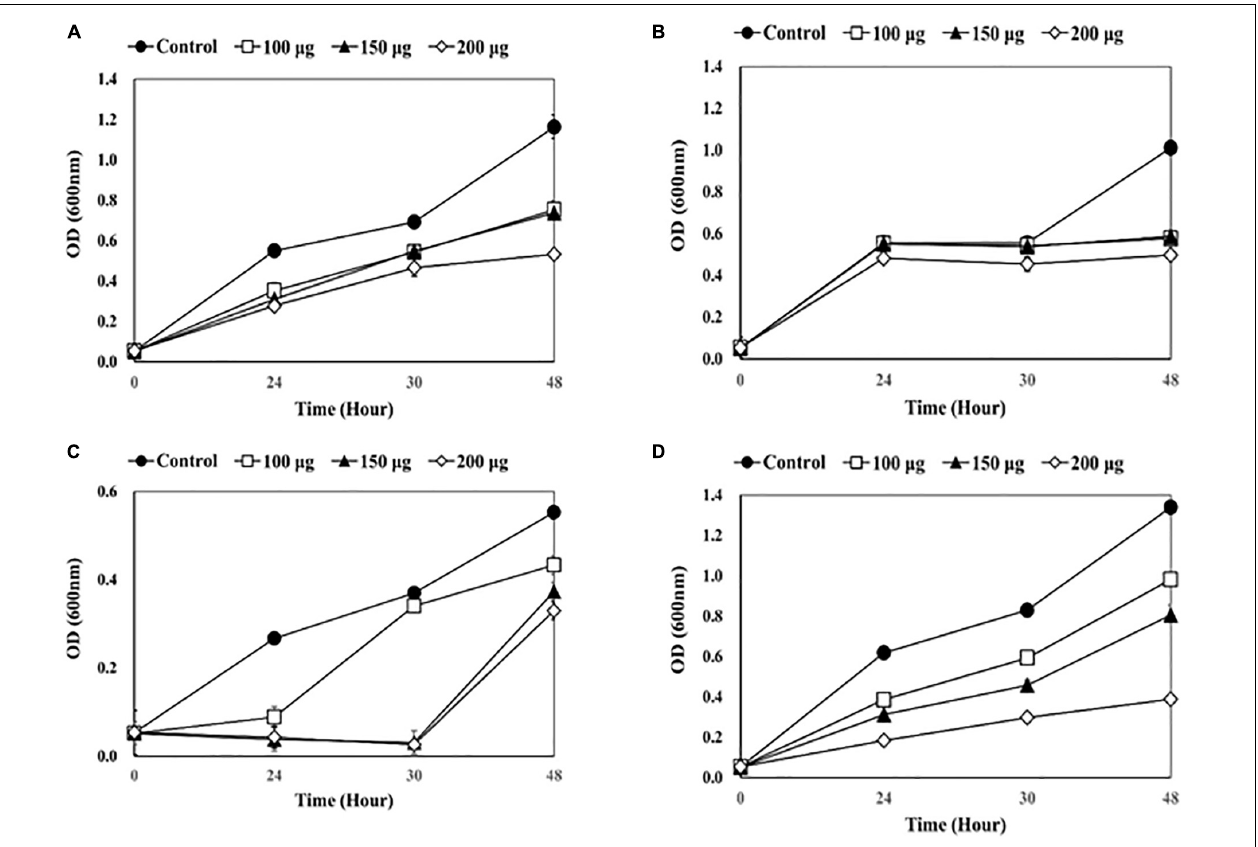
FIGURE 1 | Measuring optical density (OD) after adding endolysin LysSS to catheter solution. (A) 1-5652, (B) 2-5652, (C) 3-5655, (D) 3-5652-A. These results were statistically evaluated and expressed with standard deviation error bars from three independent